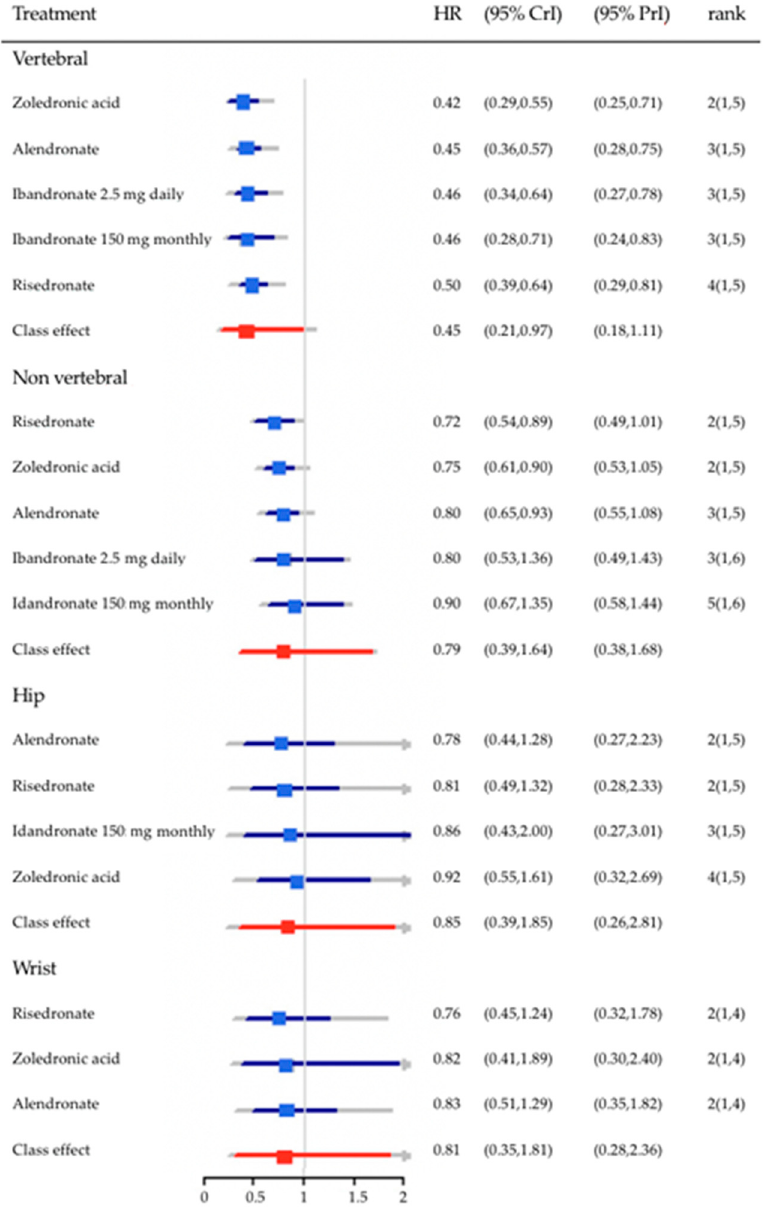
Figure 1. Hazard ratios (HR) and 95% credible intervals (CrI) for the effect of treatment relative to placebo by fracture outcomes. Blue—pooled effects; Red—class effects; Grey: 95% prediction intervals (PrI); median ranks and 95% CrI are displayed in the right hand column (as reprinted with permission from Ref. [17]. Copyright 2022, Elsevier).